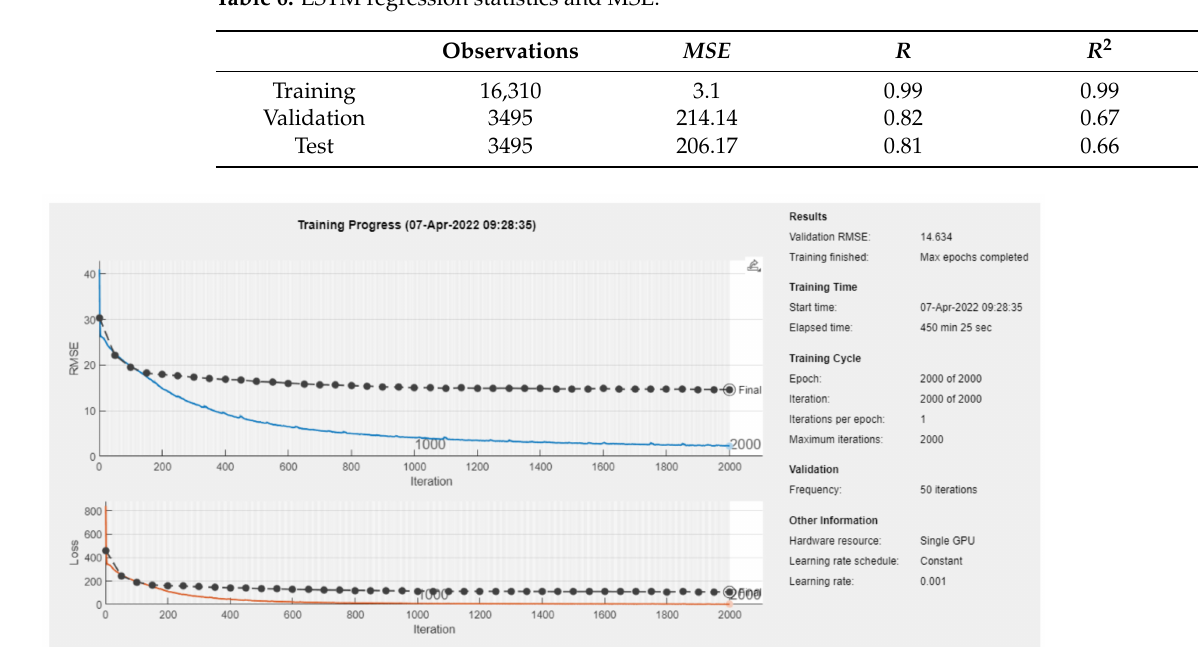
Table 6. LSTM regression statistics and MSE.